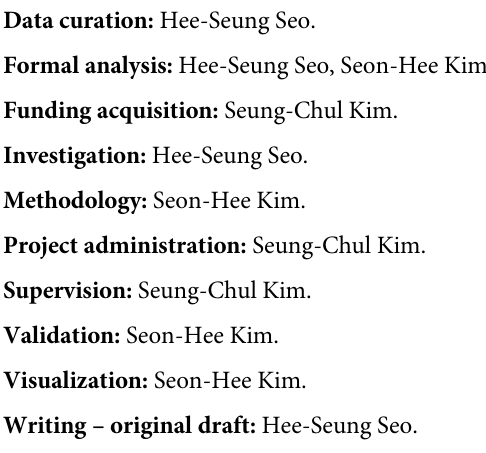
S1 Table. Variable sites (substitutions and indels) found in Phedimus